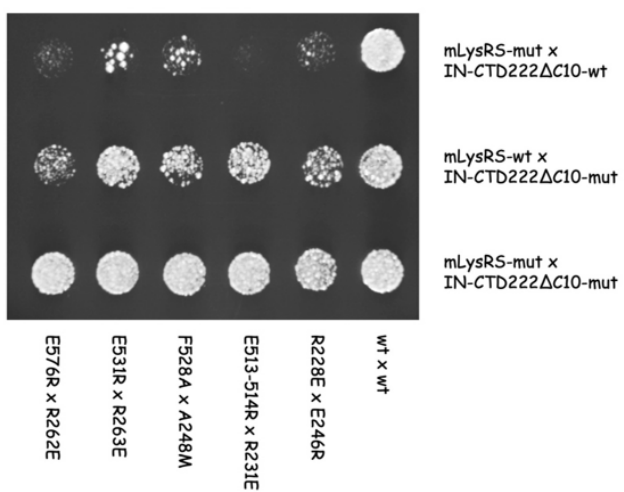
Figure 9. Two-hybrid analysis of compensatory mutations in mLysRS and IN-CTD. Mutants of the CTD of HIV-1 integrase (IN-CTD222 ∆ C10) were co-expressed with mutants of mLysRS in the two-hybrid system, as described in the legend of Figure 8. Cells co-expressing wild-type or mutants of mLysRS with wild-type IN-CTD222 ∆ C10 (first row), wild-type mLysRS with wild-type or mutants of IN-CTD222 ∆ C10 (second row), or a mutant of mLysRS with a mutant of IN-CTD222 ∆ C10 (third row) were grown in a galactose-containing medium in the absence of leucine. Yeast cells expressing compensatory mutations were growing much faster than cells expressing a single of these mutations and were able to grow similarly to cells expressing the wild-type proteins.